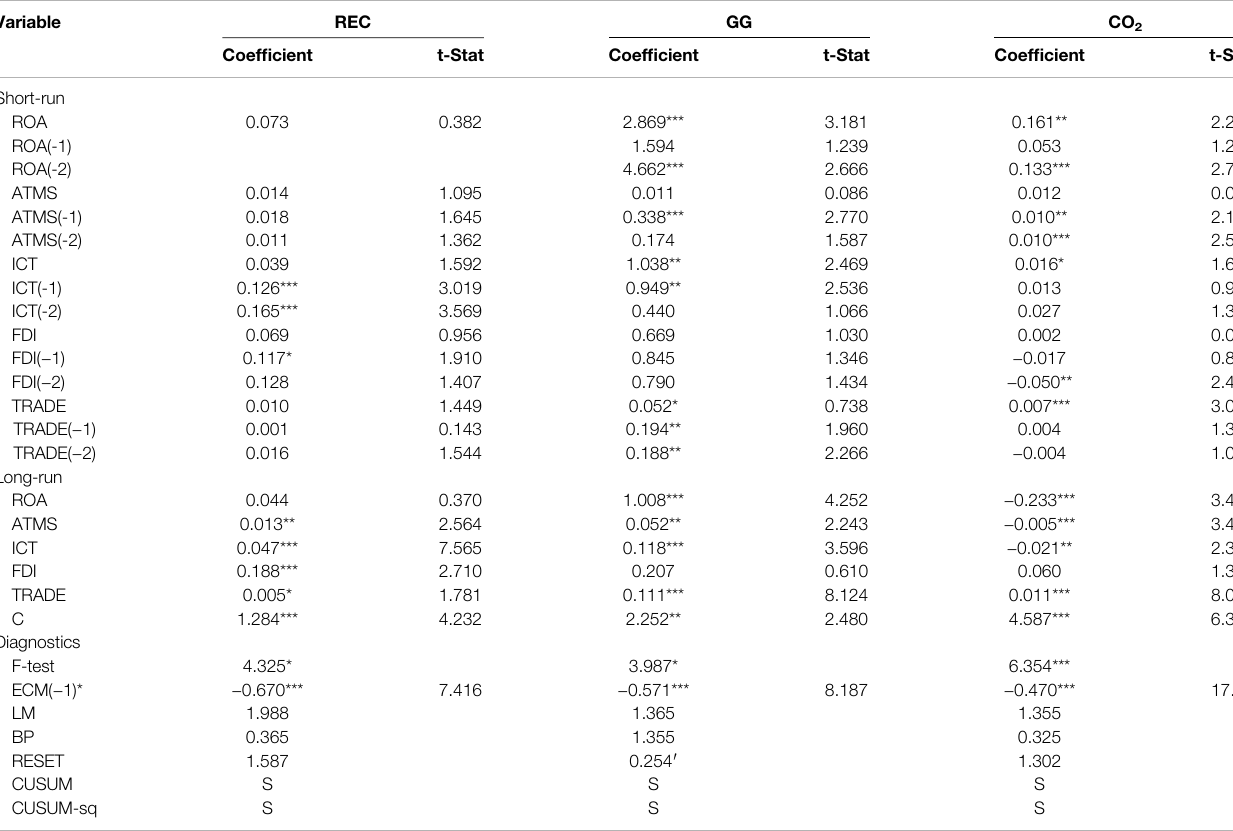
TABLE 5 | Short and long-run estimates of renewable energy consumption, green growth, and CO 2 emissions (Robustness). Variable